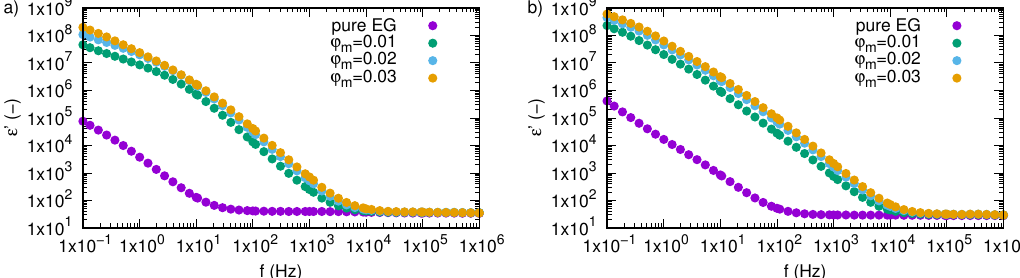
Figure 3. Real part of permittivity, ε ’, of silicon oxide lignin ethylene glycol nanofluids as function of frequency for temperature ( a ) 298.15 K, ( b ) 333.15